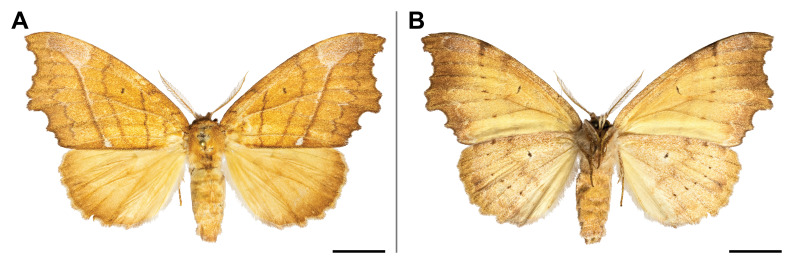
Archinadata
aurivilliusi (Kiriakoff, 1954). A. dorsal view; B. ventral view. The scale bar represents 1 cm.